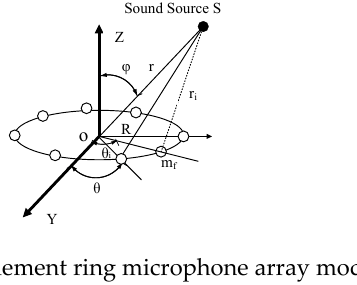
Figure 2. Microphone array model and SRP-PHAT energy map.